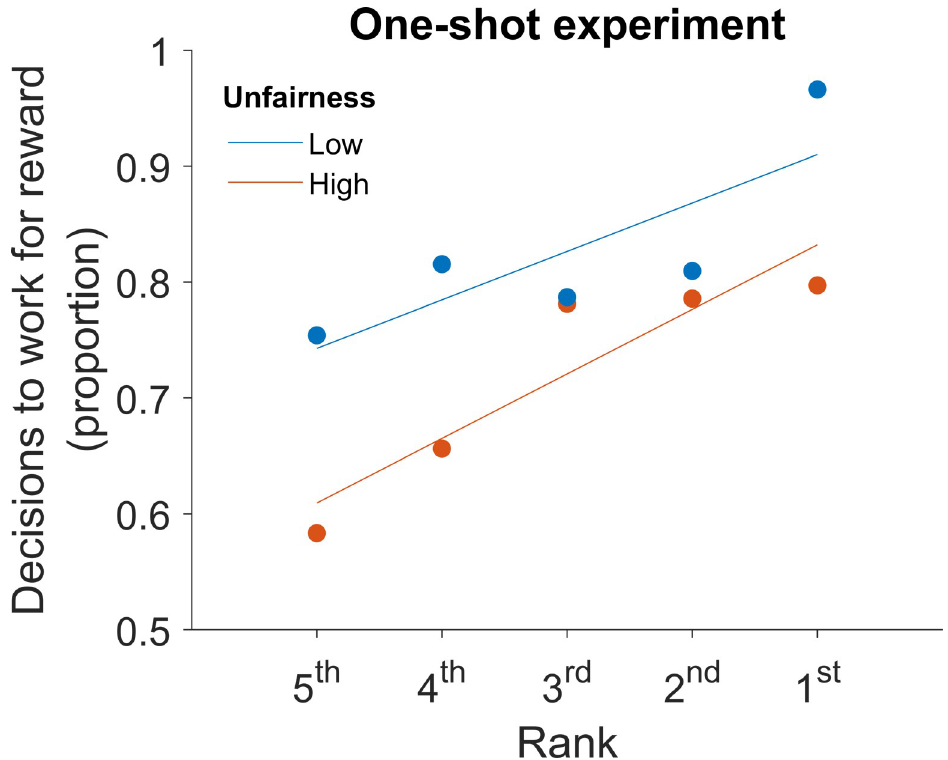
Fig 2. Motivation to work is higher when the distribution of rewards is fair and the rank of the reward is high, despite the same level of absolute reward. The plot illustrates the results from a one-shot experiment conducted on an online labour market platform. Each dot represents the proportion of participants who decided to perform an additional task for a bonus reward of £0.24, which was presented either in a relatively fair (blue) or unfair (red) context, and either as the 5 th , 4 th , 3 rd , 2 nd or 1 st best reward. The lines represent the best fitting line based on the Ordinary Least Squares method. Participants were more likely to accept the offer of £0.24 when its rank was high than when it was low, and when the rewards of all participants were fairly distributed than when they were unfairly